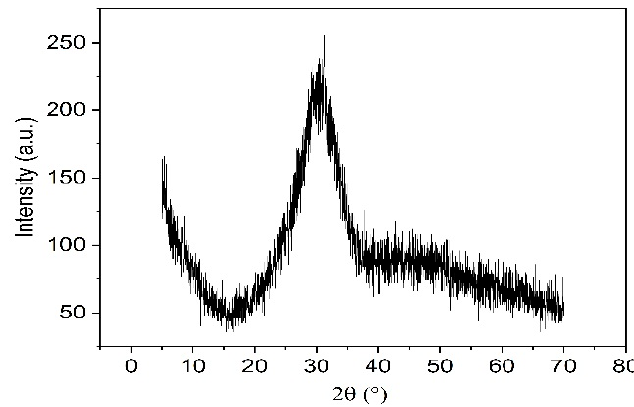
Figure 1. XRD pattern of pristine slag.